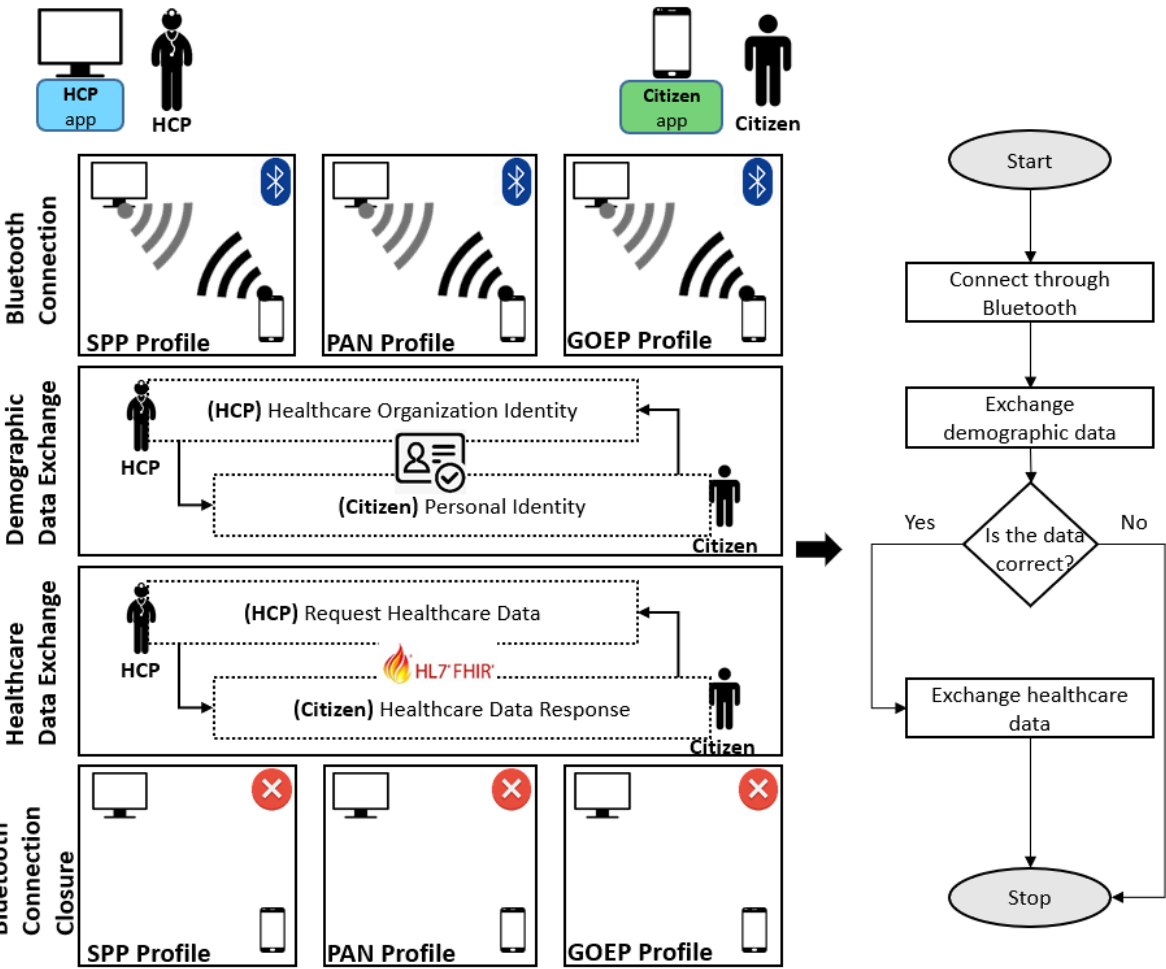
Figure 5. Device-to-Device (D2D) Protocol process following the Bluetooth SPP, Bluetooth PAN and the Bluetooth GOEP